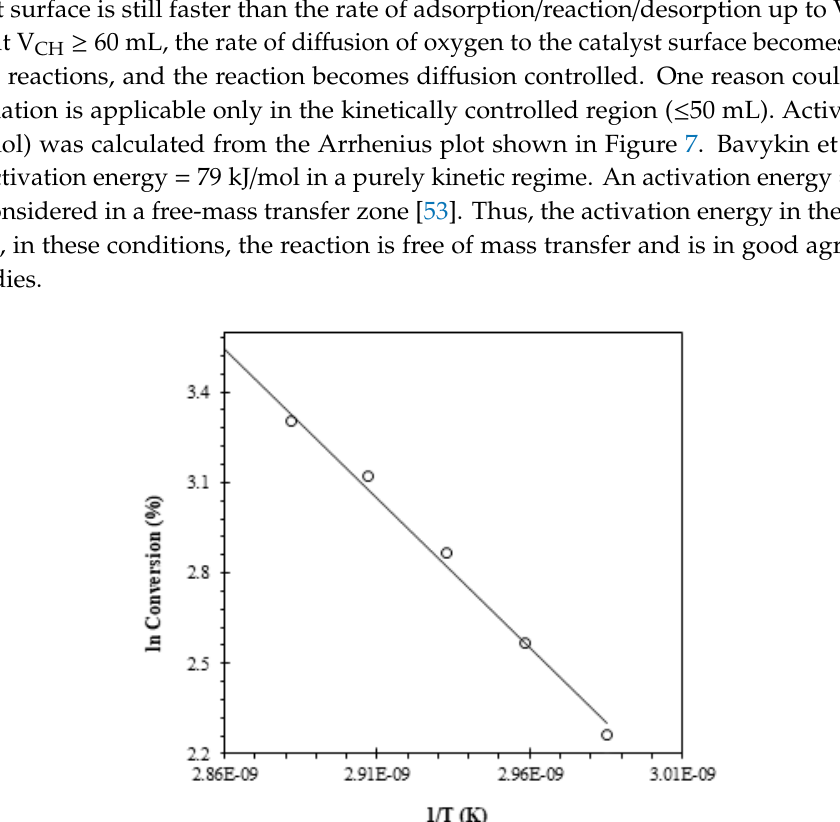
Figure 8. ( a ) Reuse of the catalyst, ( b ) separation of the catalyst from reaction medium. Conditions: Cat: 0.15 g, vol: 20 mL, pO 2 : 570 Torr, time: 210 min, temp: 80 °C, flow rate: 40 mL/min. 4. Conclusions The catalysts (Mn-ferrite and Ca-doped Mn-ferrite) were efficiently used for the synthesis of COH/RCOR from the oxidation of CH in the presence of molecular oxygen under solvent-free conditions in a self-designed reactor (GBR reactor). The catalyst shows good productivity values of 366.17 and 379.38 mmolg − 1 h − 1 for Mn-ferrite and Ca-Mn-ferrite, respectively, at optimal conditions. The synergetic effect of Ca doping on the catalytic activity of MnFe 2 O 4 was theoretically explored and corelated with experimental observations. The only discrepancy of Ca doping was reducing the magnetic properties of MnFe 2 O 4 . Furthermore, the reaction shows no mass transfer effect and it follows the Langmuir–Hinshelwood mechanism for the competitive adsorption of CH and oxygen. These catalysts are truly heterogenous with extended life spans and will be a green alternative to existing industrial processes.